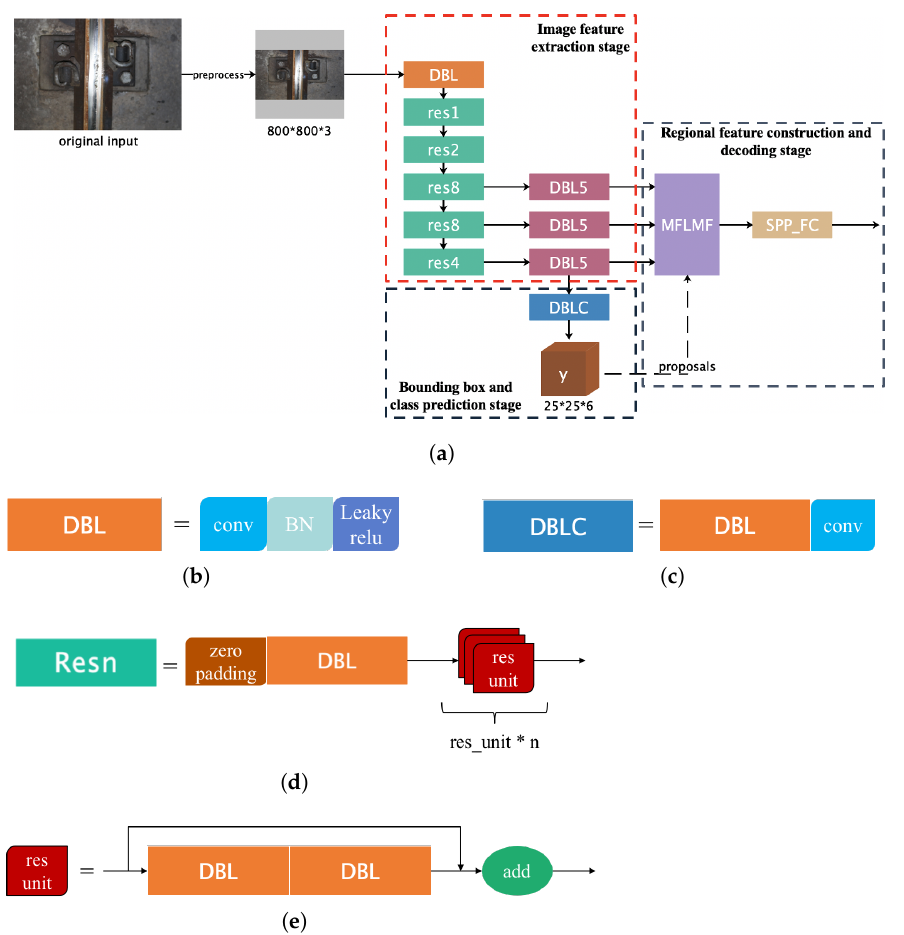
Figure 11. ( a ) The architecture of the bifurcation-fusion-based encoder part (YOLO-MFLMF); ( b ) DBL module; ( c ) DBLC module; ( d ) the module of Resn; ( e ) sketch map of the res unit. Note that the numbers in figure ( a ) indicate the number of blocks or